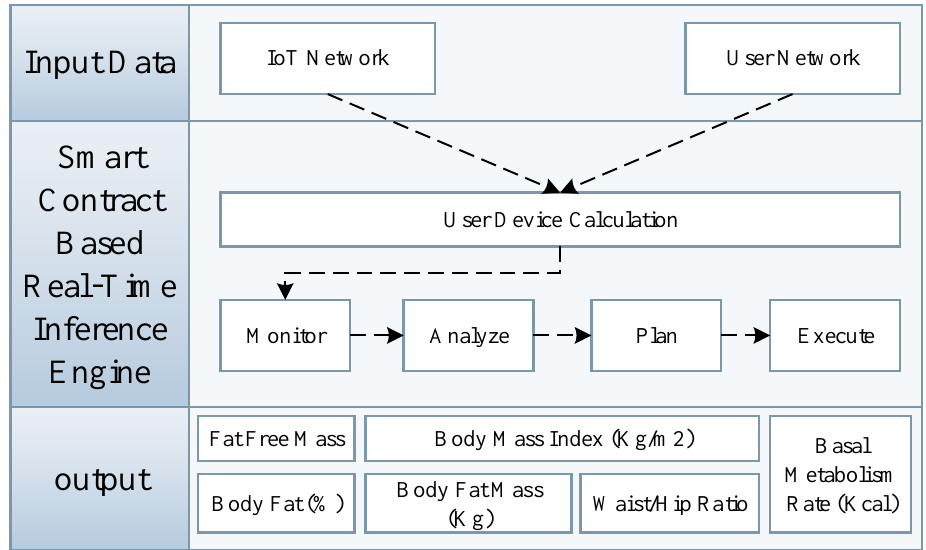
Figure 6. Enhanced smart contract for intelligent fitness service based on real-time inference engine The body measurements data thata re based on the user profile and IoT fitness device data are used to derive new knowledge, such as Fat-Free Mass ( FFM ), Body Mass Index ( BMI ), Body Fat Percentage ( BFP ), Body Fat Mass ( BFM ), Waist/Hip Ratio ( WHR ), and Basal Metabolism Rate ( BMR ), as defined in the smart contract, as shown in Figure 7.